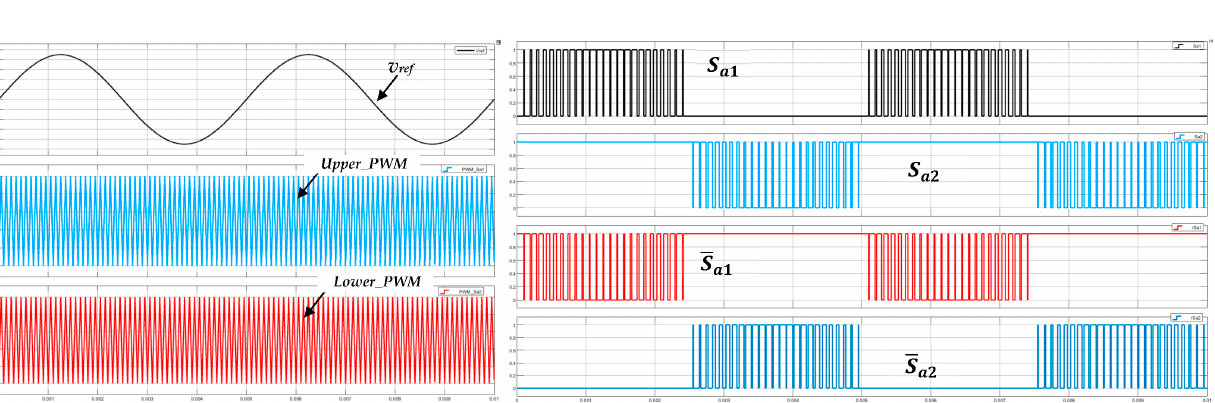
Figure 9. NPC-waveforms of the per-unit reference voltage, PWM carriers, and switching signals.